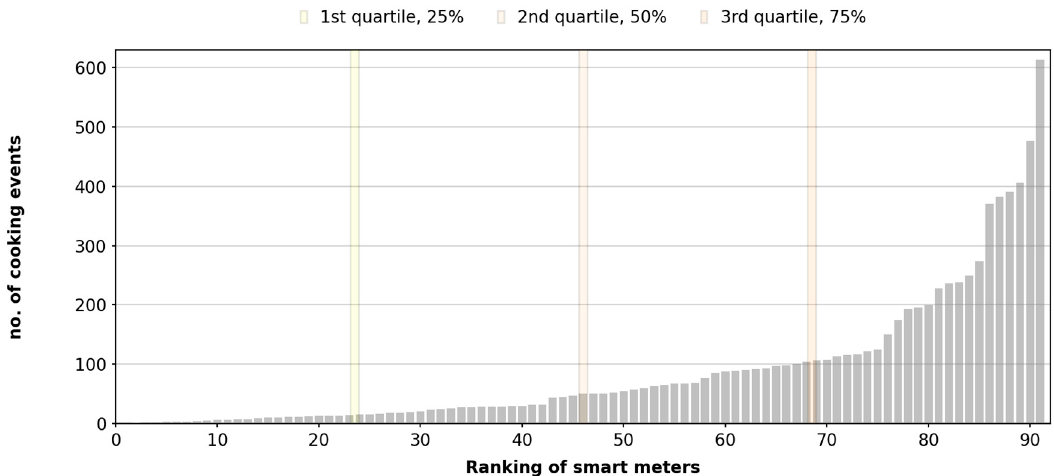
Figure 4. Total number of cooking events per smart meter, ordered by number of events. To explore differences between households, three example households have been se- lected to represent low (1st Quartile), medium (2nd quartile), and high usage users (3rd quartile). In all households, usage decreased after the Honeymoon period ended (Figures 5–7), and the low use household stopped using the appliance entirely.